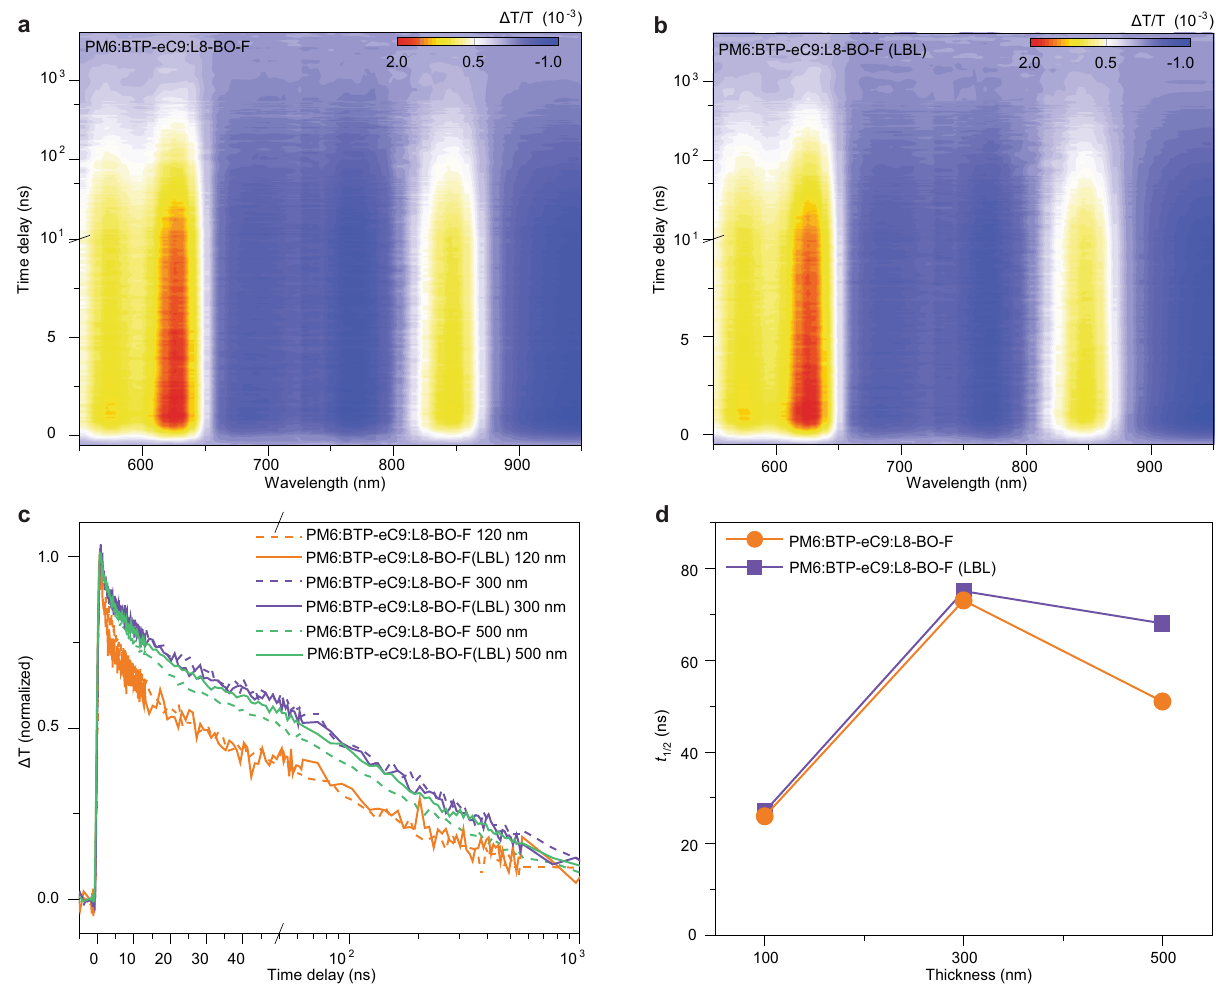
Fig. 5 Charge recombination dynamics. TA data recorded from ( a ) 300 nm-thick PM6:BTP-eC9:L8-BO-F blend. b 300 nm-thick LBL-processed PM6:BTP- eC9:L8-BO-F blend. c Normalized time-resolved curves probed at 940 nm in the fi lms of different thicknesses prepared by different methods. d The half- decay lifetimes estimated from the ns kinetic curves for different